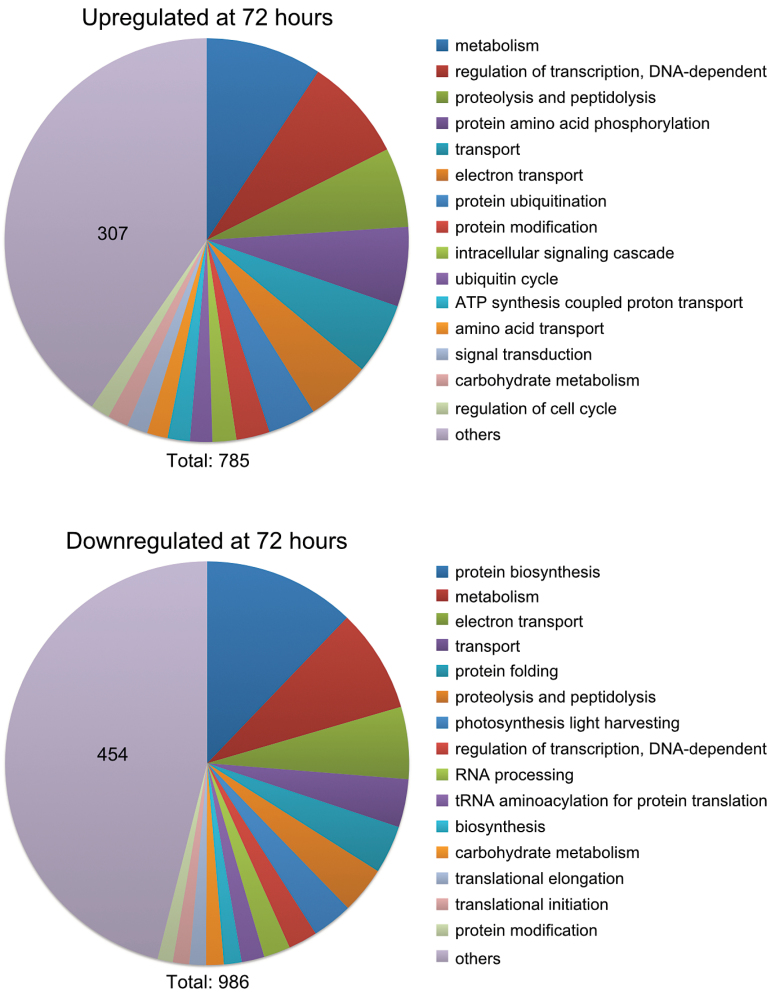
GO analysis of significantly regulated genes after 72h of nitrate deprivation. The dataset was divided into up- and downregulated genes and analysed for process GO terms. The 15 most frequent GO terms are listed, and the rest were combined into ‘others’. The number in the ‘others’ section indicates the number of hits within this category. The total number of GO term hits is listed below the graphs.